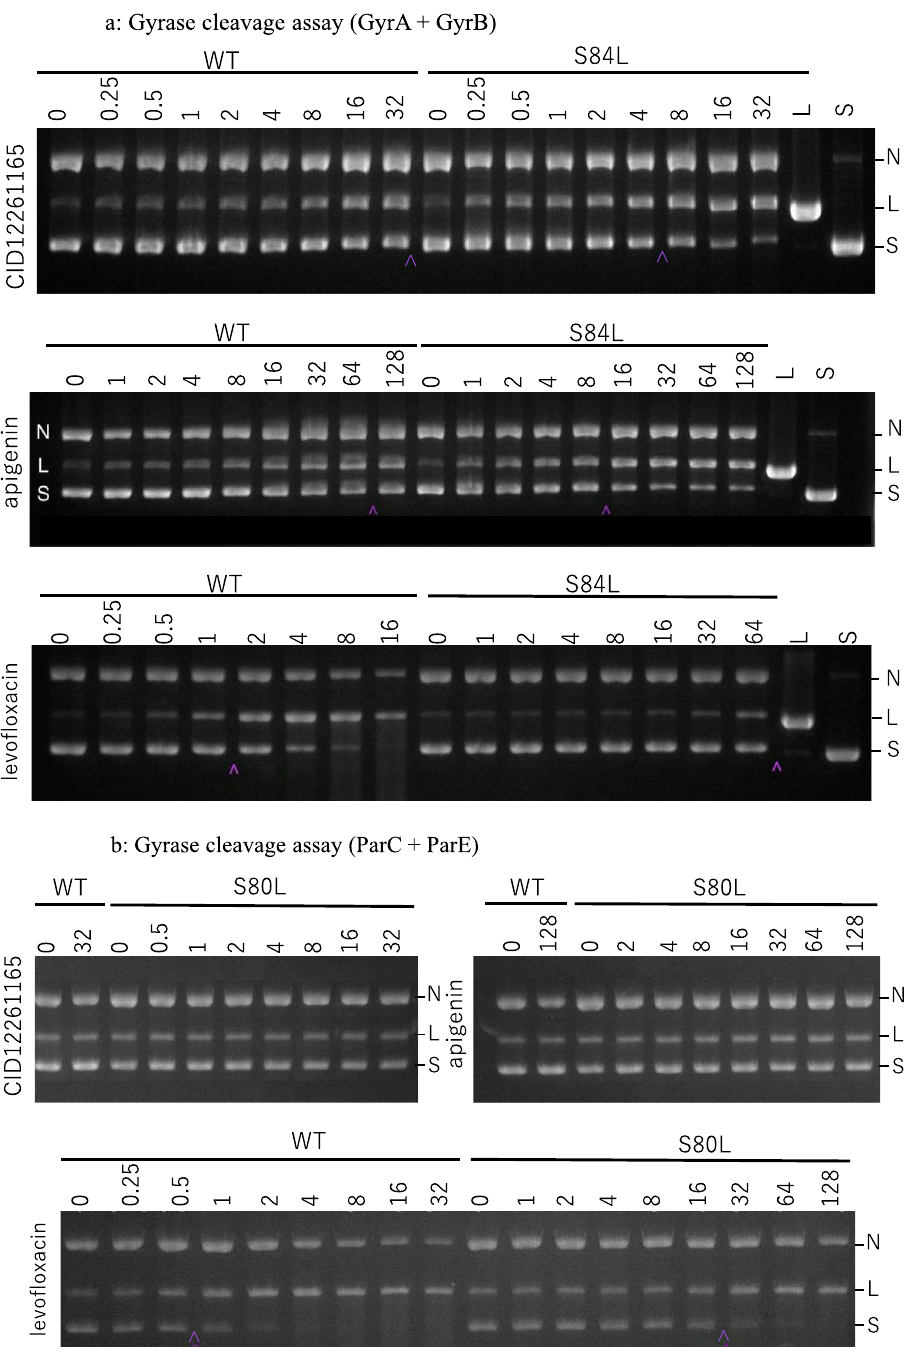
Figure 1. (a) In vitro DNA cleavage assay showing CID12261165 and apigenin specifically inhibited mutated DNA gyrase, whereas the mutant was resistant to levofloxacin. In the figure, ‘S’ indicates supercoiled substrate plasmid, ‘L’ is the linearized form of the plasmid, and ‘N’ indicates the nicked form of the plasmid. Decreased population of ‘S’ and corresponding accumulation of ‘L’ and ‘N’ forms indicate failure of DNA re-ligation activity by effective drugs after cleavage of the substrate DNA by DNA gyrase. ( b) Whereas levofloxacin inhibited enzymic activity of topoisomerase IV, CID12261165 and apigenin neither inhibited mutated or wild-type topoisomerase IV. ( c) In vitro DNA supercoiling assay showing enzymatic activity of CID12261165 and apigenin mutated form of DNA gyrase, whereas the mutant was resistant to levofloxacin. In the figure, ‘R’ indicates relaxed plasmid (substrate), and ‘S’ is the supercoiled form of the plasmid (reaction product). WT: wild-type GyrA + GyrB; S84L: GyrA(S84L) + wild-type GyrB. S. aureus strain FDA209P was the source of wild-type recombinant GyrA and ParC, and strain Mu50 was the source of recombinant S84L GryA and S80F ParC with one mutation, respectively. Decreased population of ‘S’ and corresponding accumulation of ‘R’ forms indicate failure of DNA supercoiling activity by effective drugs. Carets (hat symbol) in the ( a,b ) show IC50 values. Each image is cropped from gels by different experiments, and the original images are provided as supplemental